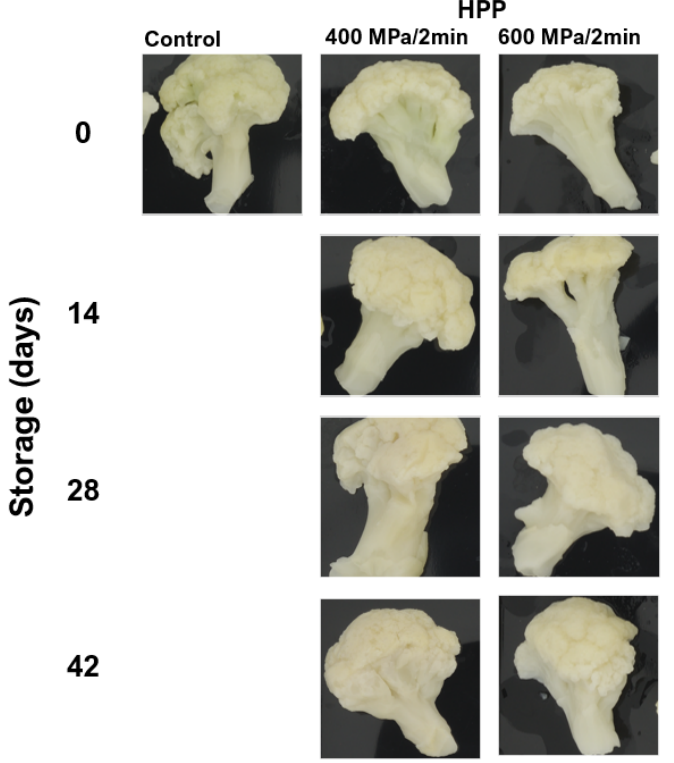
Figure 1. Visual comparison of selected pieces of cauliflower after HPP treatment of 400 MPa/2 min until day 42.